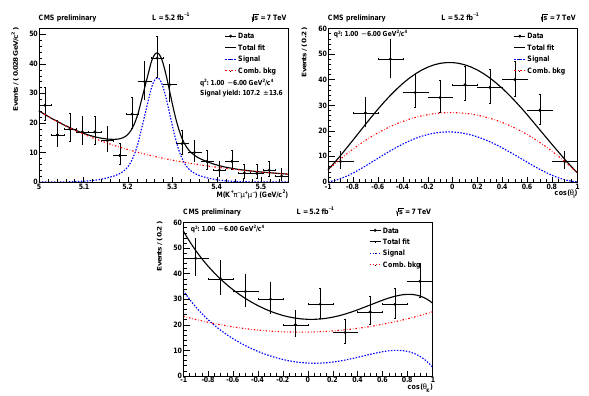
Figure 6. The K + π − µ + µ − invariant mass (top left), cos θ L (top right), and cos θ K (bottom) distributions for the 1 < q 2 < 6 GeV 2 region, along with the projections of the